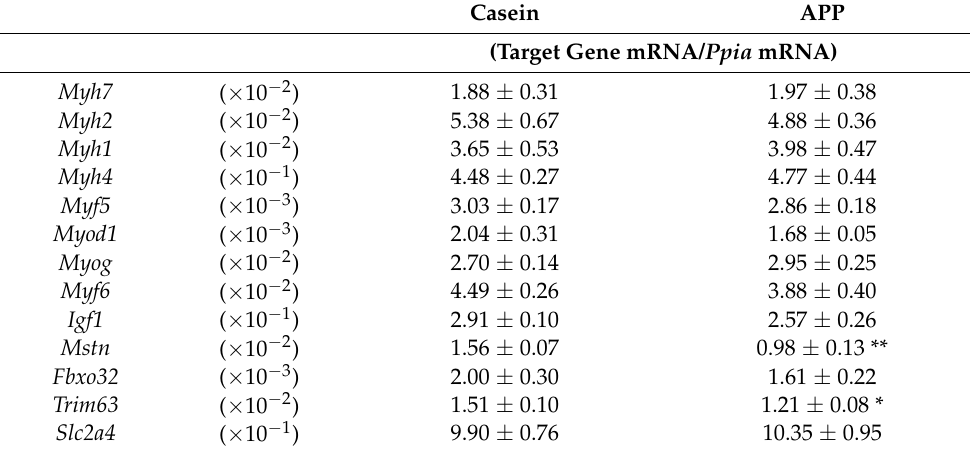
The gene expressions of myosin heavy chains and regulators of muscle mass and metabolism of normal fat-casein diet group (Cas, n = 8) and normal fat-APP diet group (APP, n = 8) after 7 days of feeding are shown. Data are expressed as the mean ± standard error (SEM). Asterisks indicate significant differences compared to the Cas group by unpaired Student’s t-test (*, p < 0.05; **, p < 0.01).